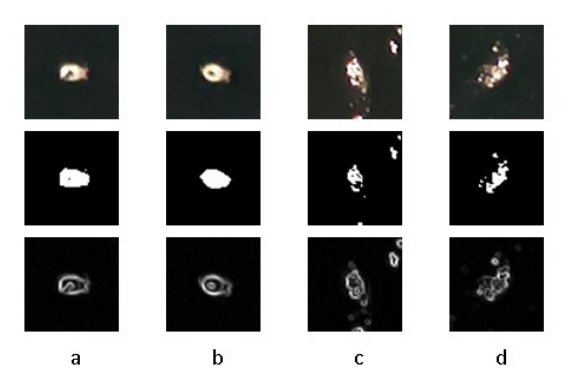
Figure 2. Top row: candidate sub-images extracted from the original data; center row : segmentation results; bottom row : gradient magnitudes. Columns a+b : Common Eider; columns c+d : sun glitter.